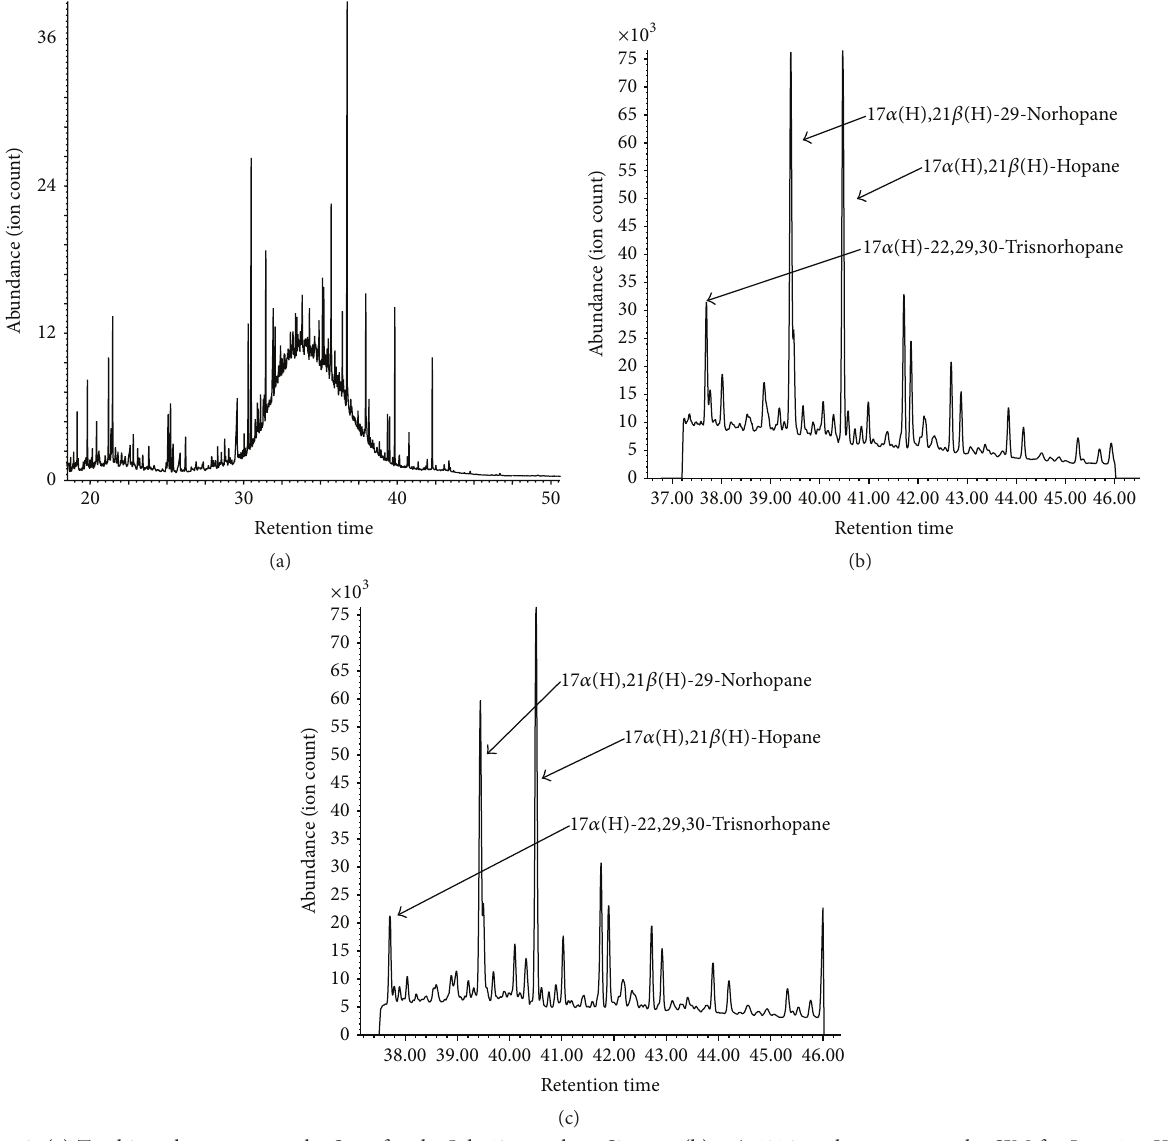
Figure 3: (a) Total ion chromatogram by Scan for the July 13 sample at Simcoe; (b) m/z 191 ion chromatogram by SIM for June 1 at York Gateway tunnel; (c) m/z 191 ion chromatogram by SIM for June 23 at